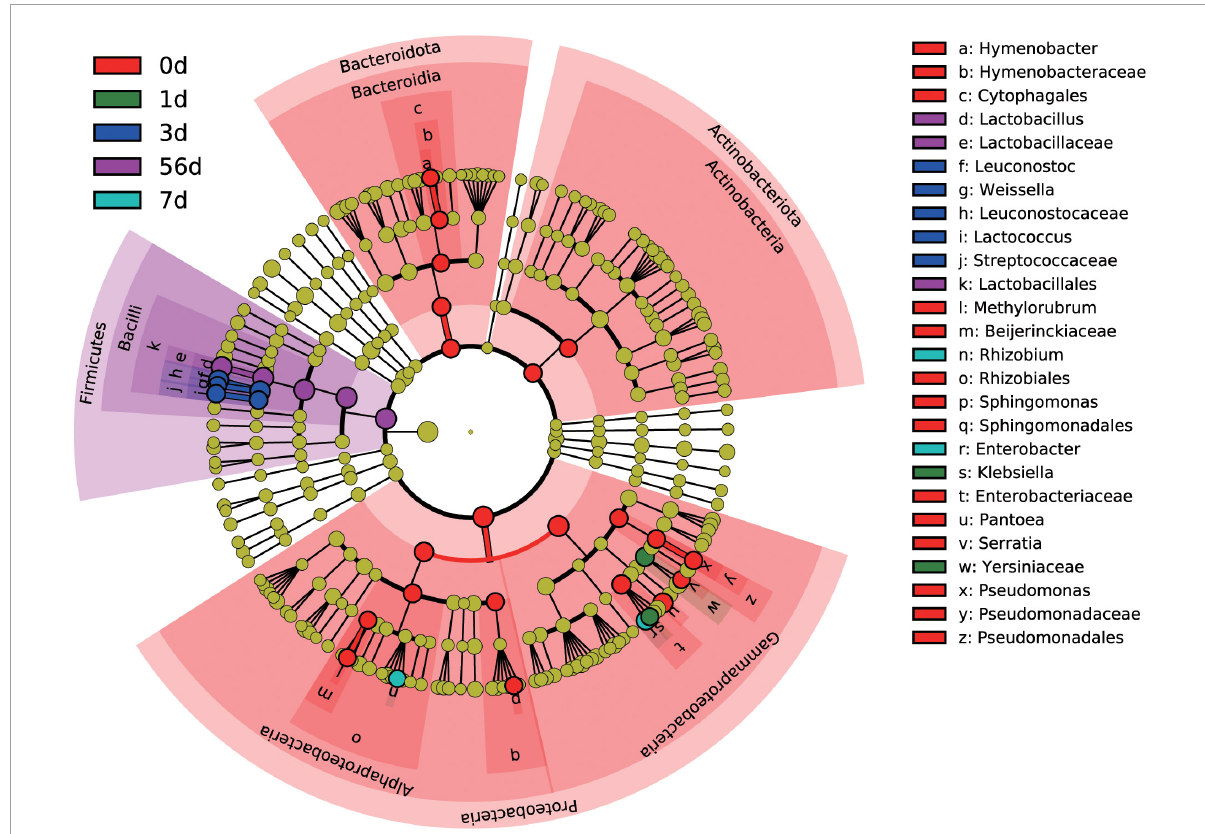
FIGURE3 Differential silage bacterial taxa ( P < 0.05, and LDA score > 4) among the different ensiling duration by